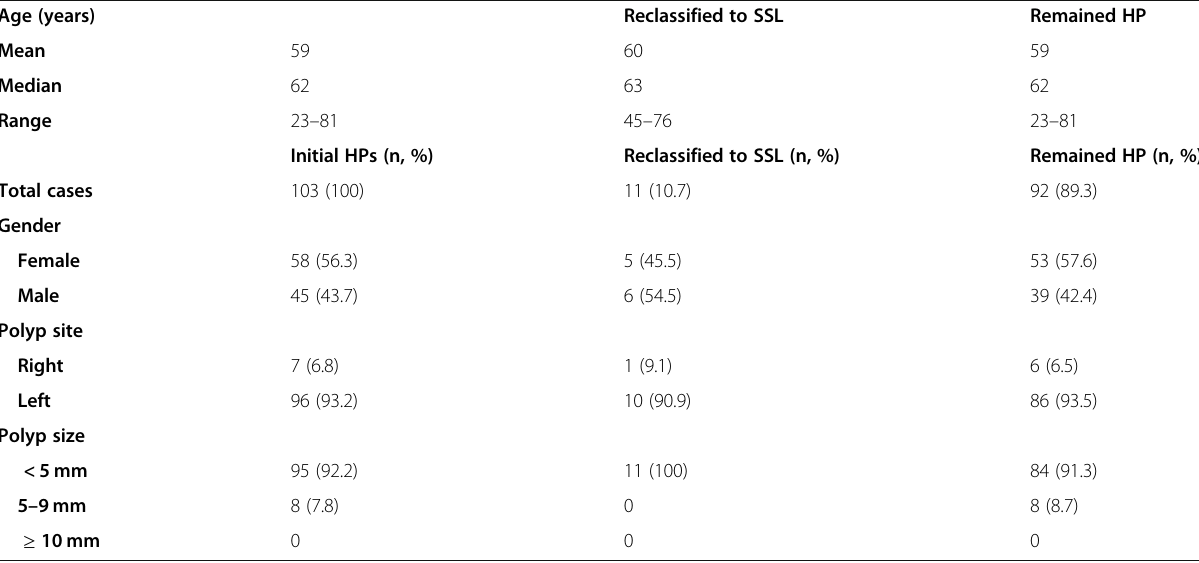
Table 1 Clinicopathological characteristics of the study population Age (years)